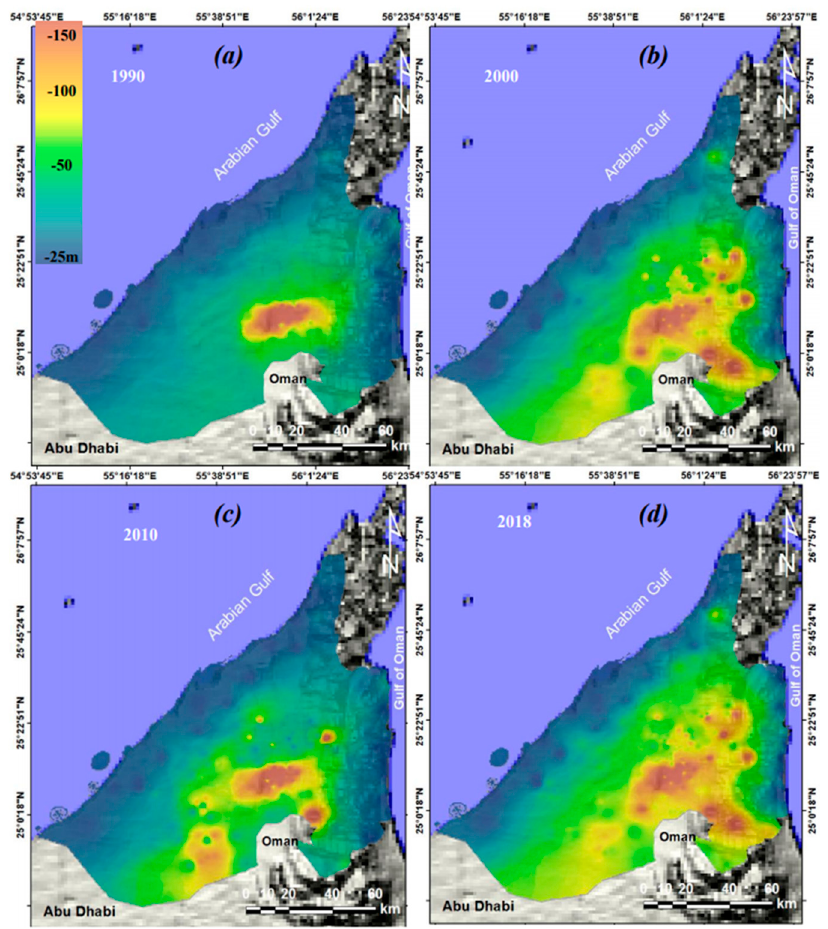
Figure 8. The graphical representation of the total area in km 2 of built-up and vegetated area changes ( a ), and their differences from 1990 to 2018 ( b ).